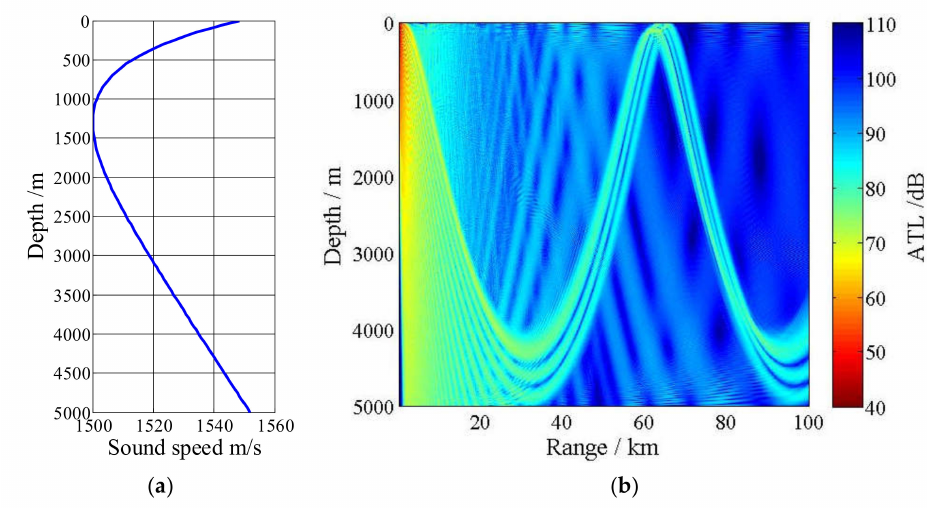
Figure 4. Simulation parameters and sound propagation in deep sea: ( a ) The sound speed profile; ( b ) The average transmission loss.